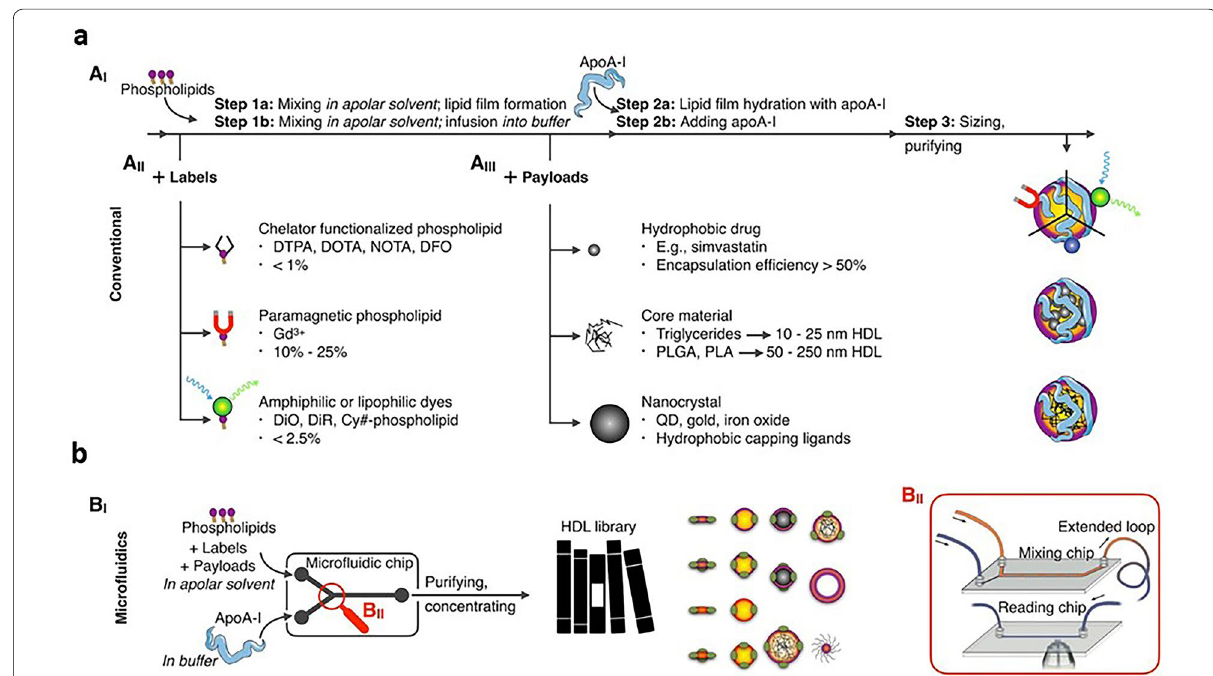
Fig. 1 a HDL mimicking NP production. (A I ) HDL mimicking NPs can be reconstituted per different “conventional” strategies and include (A II ) amphiphilic labels or